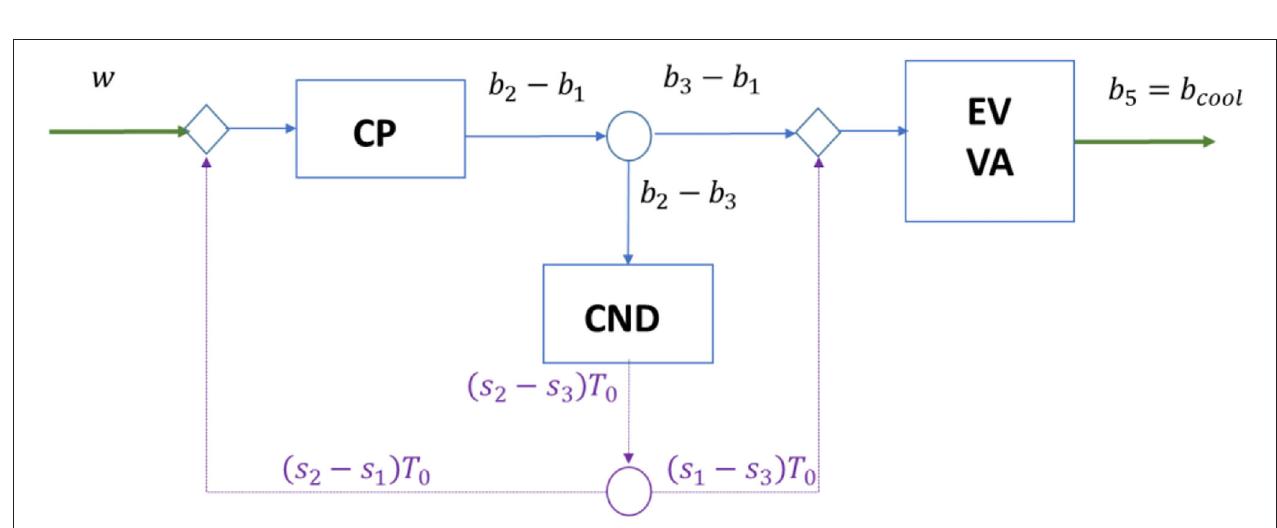
FIGURE 5 | E&S model approach with total exergy.